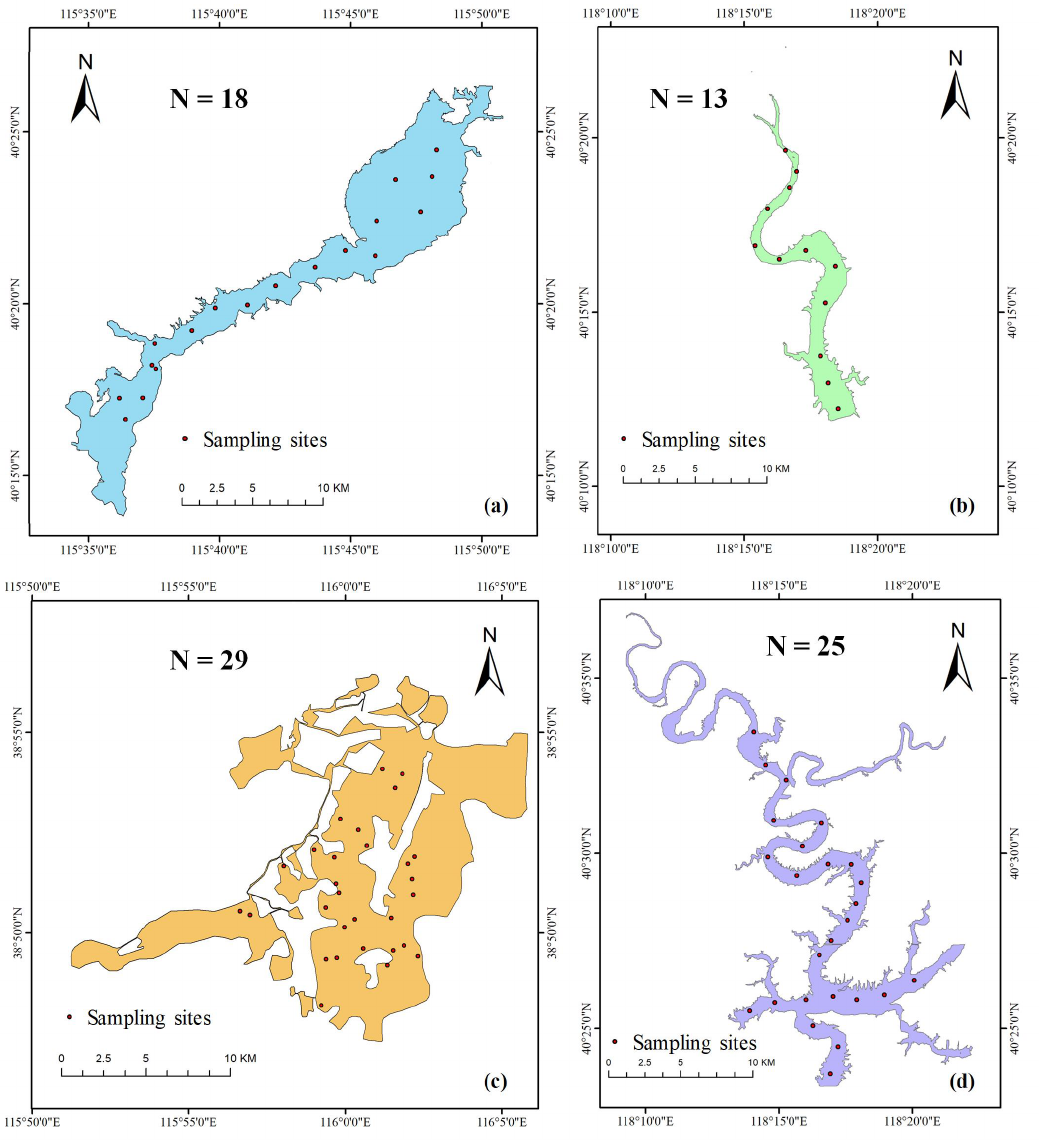
Figure 1. Distributions of the sampling sites in all study regions: ( a ) Guanting Reservoir, ( b ) Daheiting Reservoir, ( c ) Lake Baiyangdian, and ( d ) Panjiakou Reservoir in North